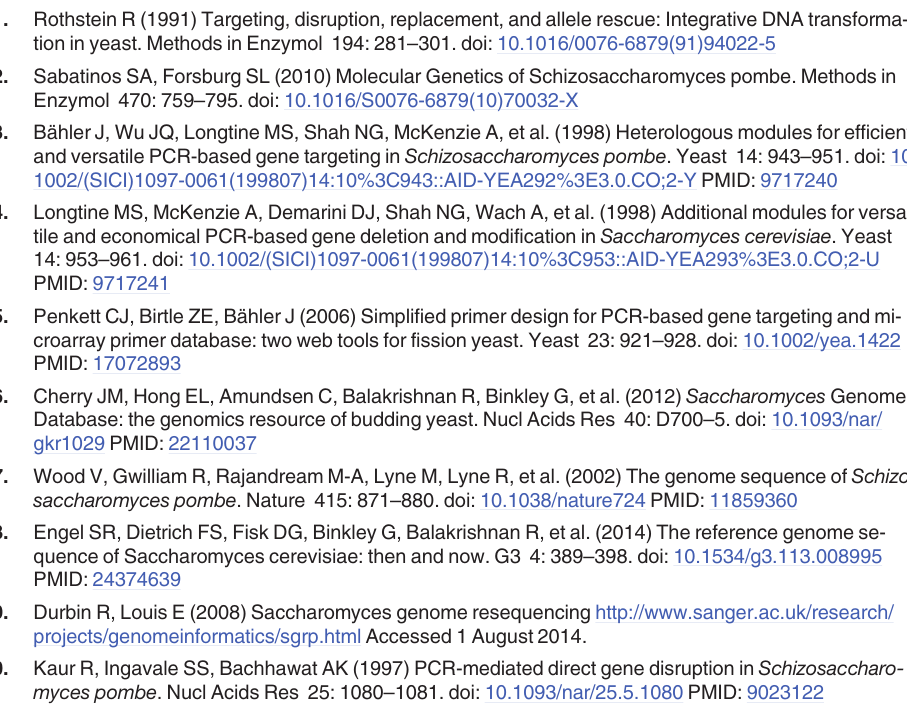
S2 Table. PRIMED for S. cerevisiae (S288C). S3 Table. PRIMED for S. cerevisiae (RM11). S4 Table. PRIMED for S. cerevisiae (SK1). S5 Table. PRIMED for S. cerevisiae (W303). S6 Table. PRIMED for S. cerevisiae